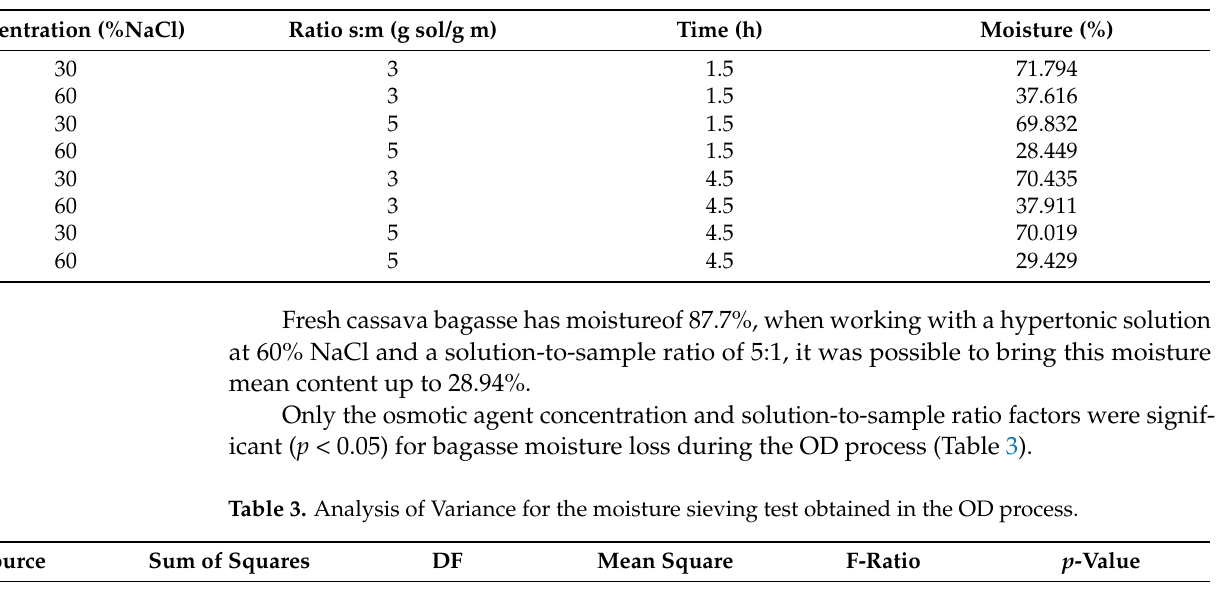
Table 2. Moisture results according to the sieving test.